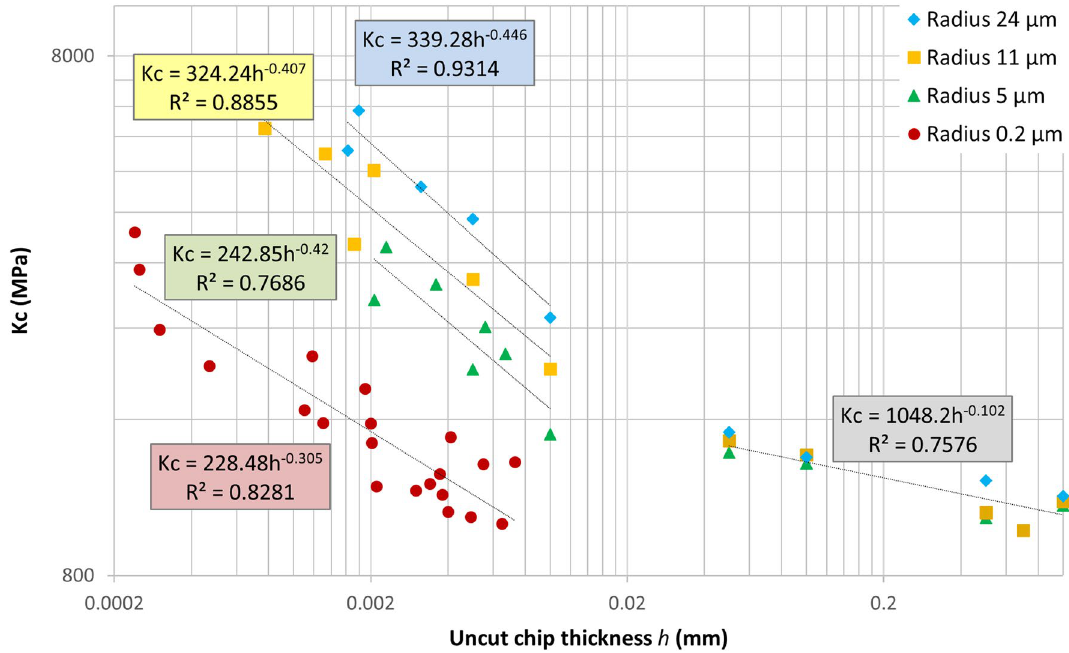
Figure 6. Plot of the measured specific cutting energy (Kc) depending on the uncut chip thickness